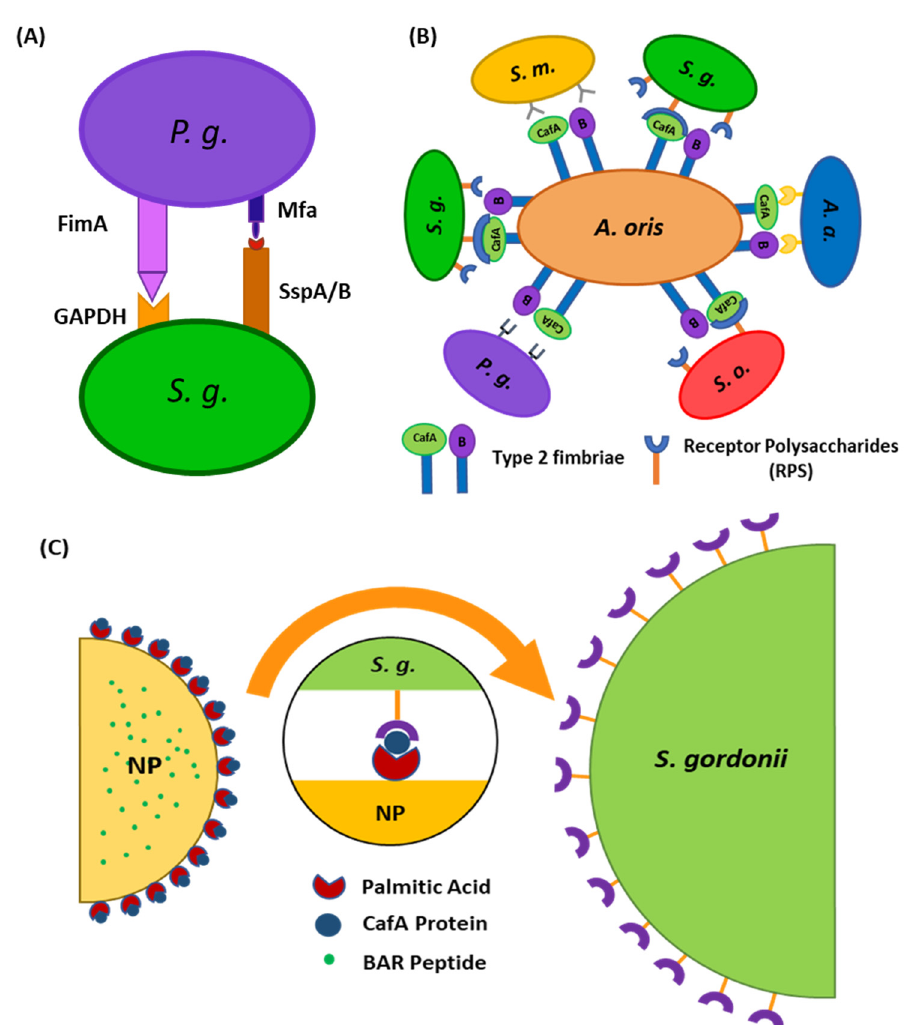
Figure1. ( A )Schematicrepresentationof P.gingivalis − S.gordonii adhesionmediatedviatheinteractionof Figure 1. ( A ) Schematic representation of P. gingivalis − S. gordonii adhesion mediated via the major (fimA) and minor fimbriae (Mfa1) of P. gingivalis with glyceraldehyde 3-phosphate dehydrogenase interaction of major (fimA) and minor fimbriae (Mfa1) of P. gingivalis with glyceraldehyde 3- (GAPDH) and motifs on SspA / B proteins of S. gordonii , respectively. ( B ) Schematic representing the phosphate dehydrogenase (GAPDH) and motifs on SspA/B proteins of S. gordonii , respectively. ( B ) specificity of adherence of coaggregation factor A (CafA). CafA is the tip fimbrillin of the type 2 fimbriae Schematic representing the specificity of adherence of coaggregation factor A (CafA). CafA is the tip of A. oris and mediates the coaggregation of A. oris with commensal receptor polysaccharide (RPS) fimbrillin of the type 2 fimbriae of A. oris and mediates the coaggregation of A. oris with commensal expressing oral streptococci. ( C ) Surface modification of nanoparticles with CafA protein will aid in receptor polysaccharide (RPS) expressing oral streptococci. ( C ) Surface modification of nanoparticles directing nanoparticles to S. gordonii for targeted delivery of BAR with CafA protein will aid in directing nanoparticles to S. gordonii for targeted delivery of BAR peptide.